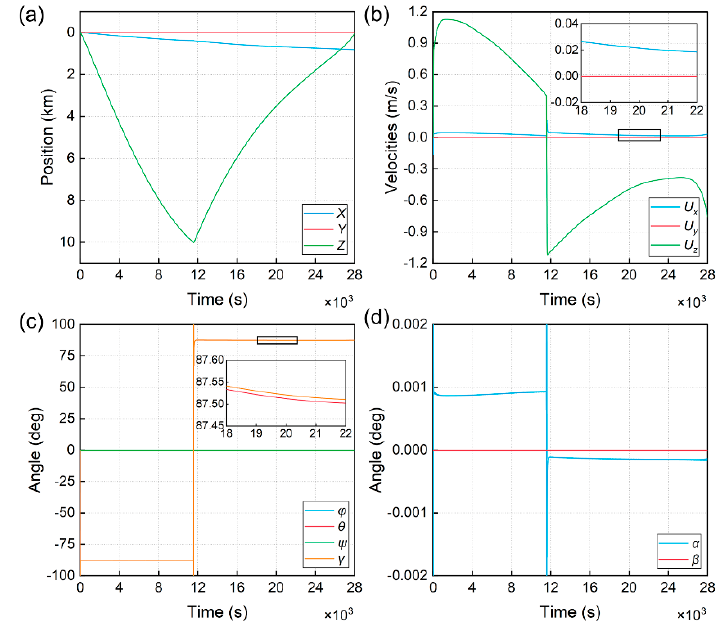
Figure 10. Simulation results in LF mode: ( a ) Position; ( b ) Velocities; ( c ) Euler angles and gliding angles; ( d ) Attack angle and side slip angle.